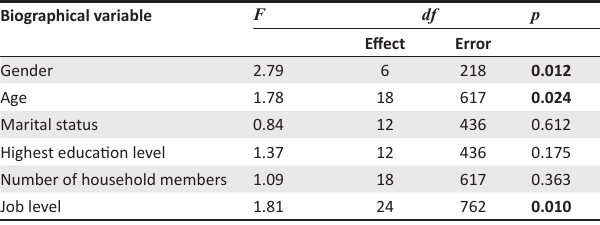
TABLE 5: Multivariate analysis of variance for the relationship between biographical variables and the importance of reward – Iteration 1. Biographical variable